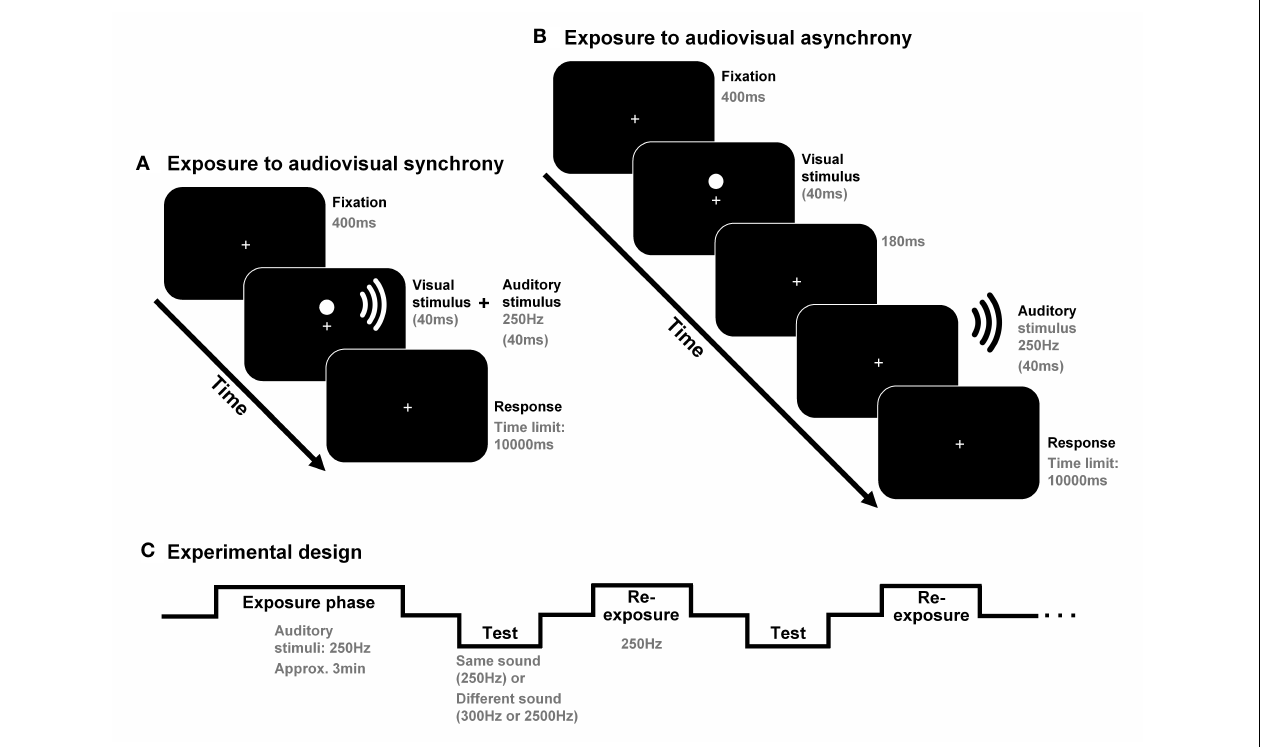
simultaneity judgments (SJs) regarding audiovisual stimulus pairs including the same tone as the one presented during the exposure phase (250Hz) or else another tone (300 or 2500Hz). Eight re-exposure audiovisual stimulus pairs (including 250Hz tones) were presented every three SJ trials [see (C)